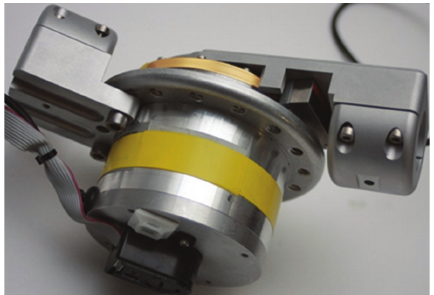
Figure 3: Actuator showing two encoders, golden read strip that is wrapped around the base of the harmonic drive gear